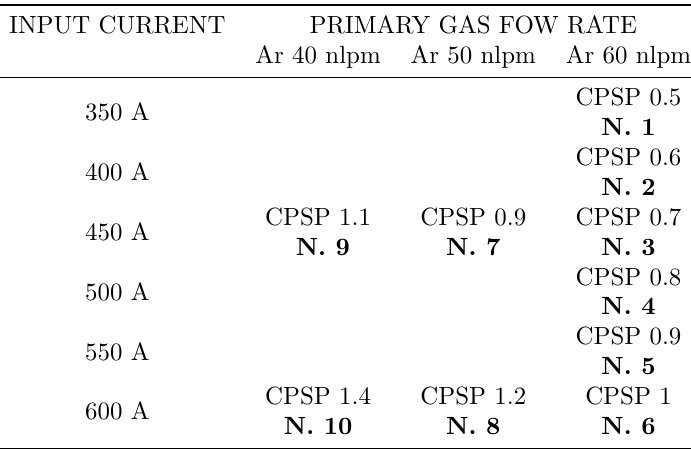
Table 1. Matrix of chosen variable parameters for experiment. Cells displays a serial number and an estimated value of CPSP for particular set of spraying